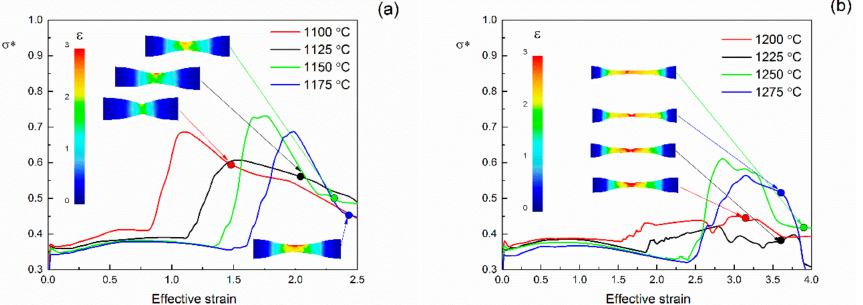
Figure 9. Dependences of stress triaxiality on equivalent strain during tensile tests at ( a ) 1100–1175 ◦ C and ( b ) 1200–1275 ◦ C (the circles are the experimental values of ε f ).